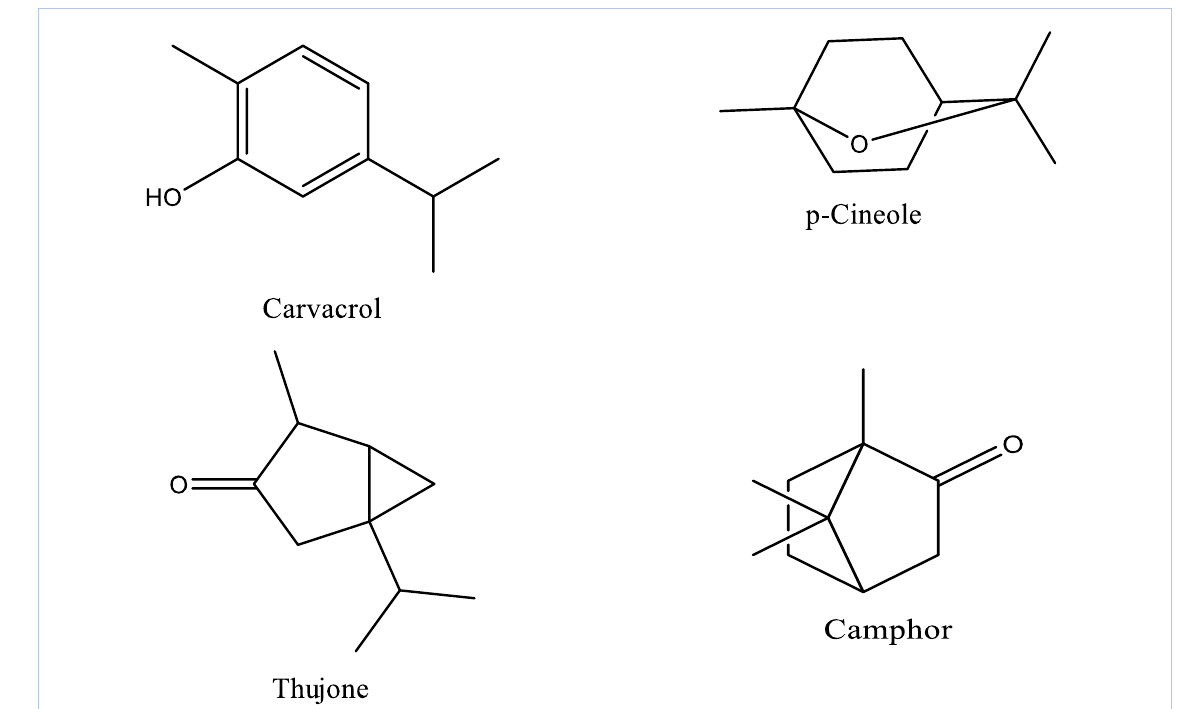
Figure 2. Molecular structures of the major compounds in EOAG.